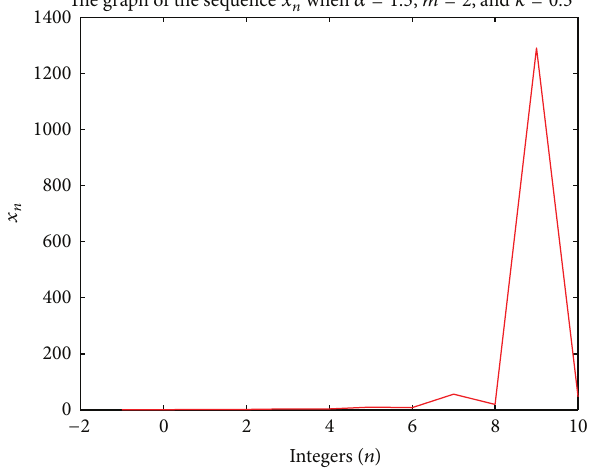
Figure 4: When 𝑚 > 1 there exists an unbounded positive solution.